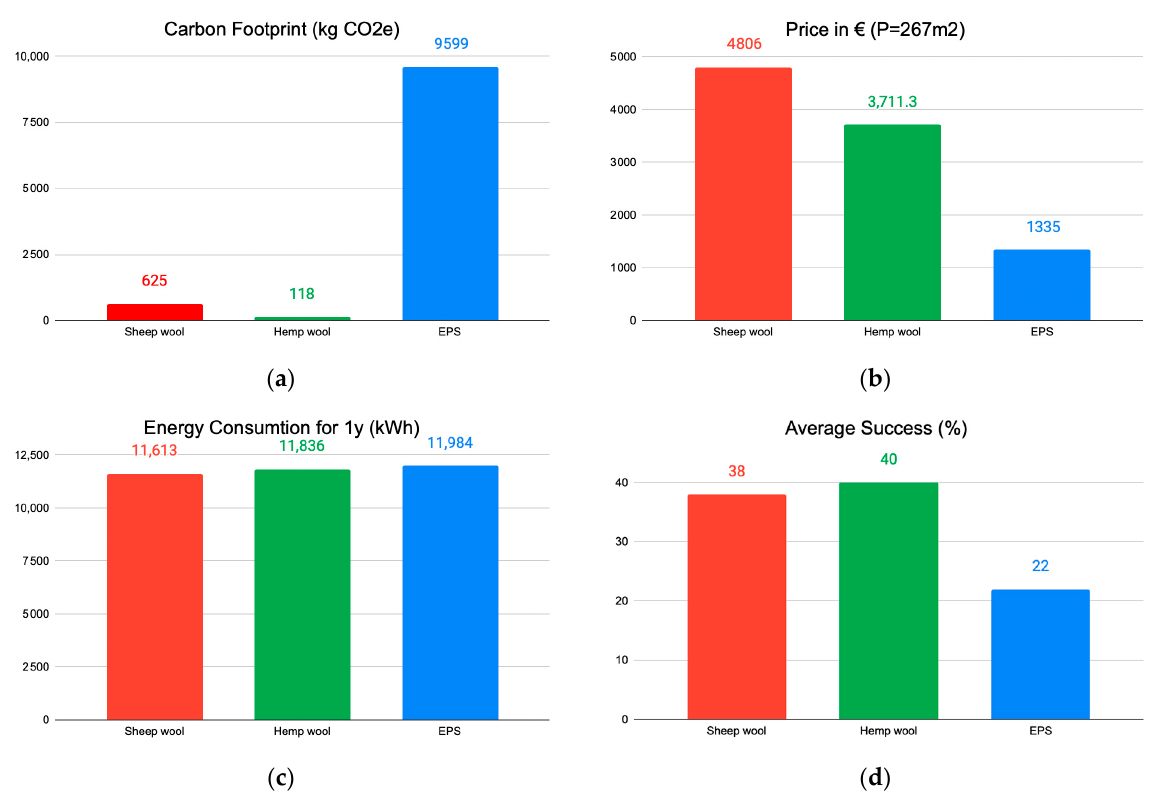
Figure 11. Synthesis of results: ( a ) Carbon Footprint, ( b ) Price, ( c ) Energy Consumption, ( d ) Average Success.